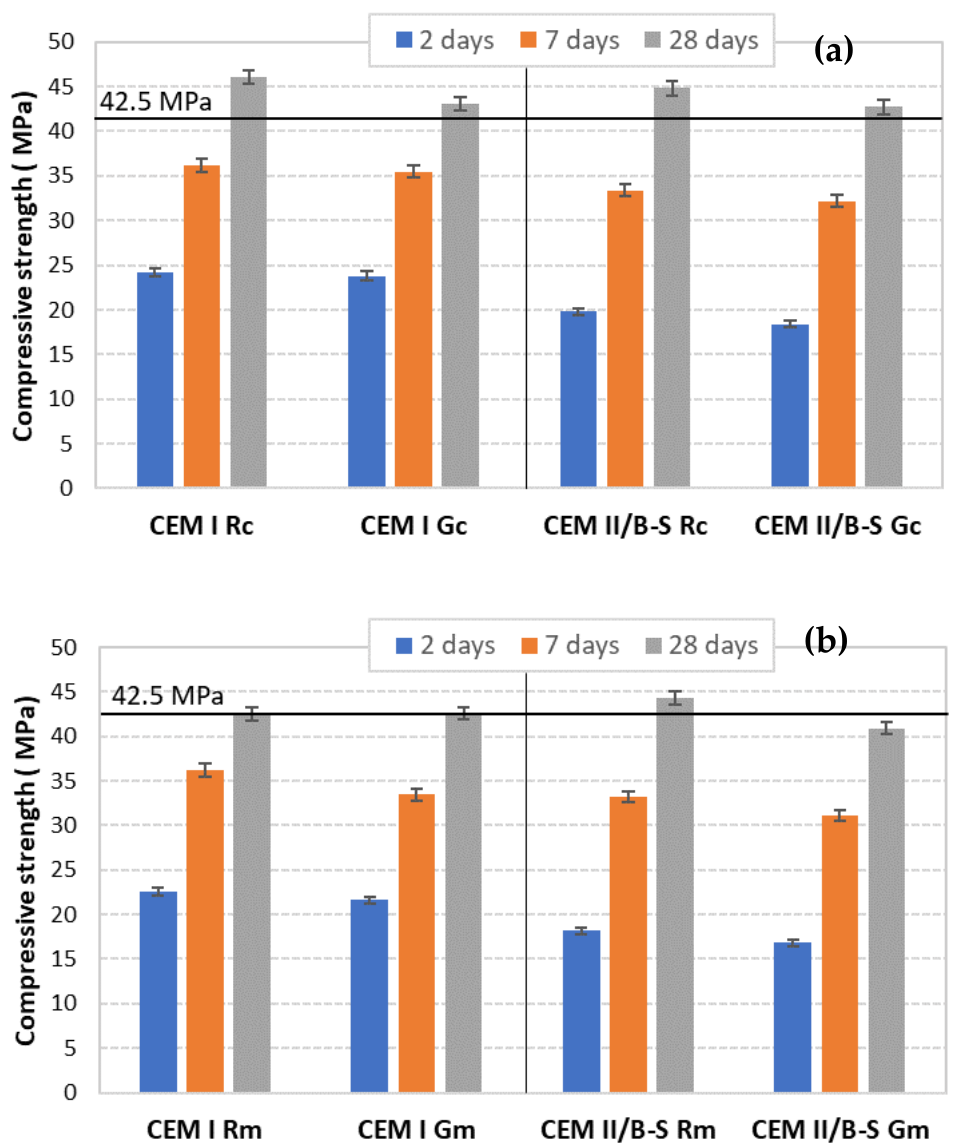
Figure 11. Compressive strengths vs. time for CEM I and CEM II B-S, with sand or WG and based on ( a ) clay; ( b )